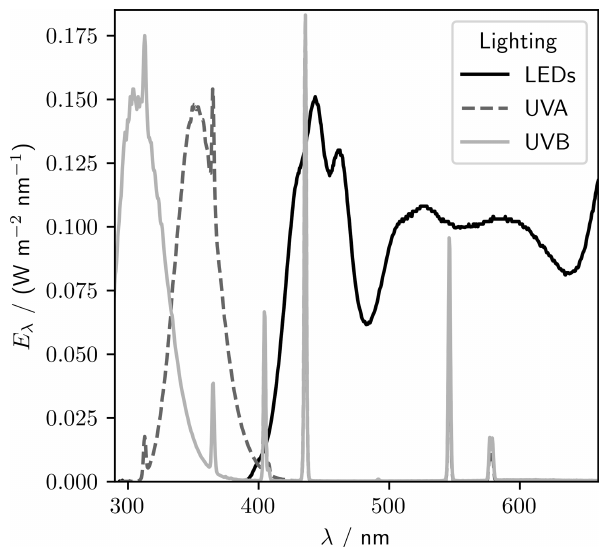
Figure 2. Spectral irradiance, E λ , for the lights in the RvG-ASIC at 1m height and room